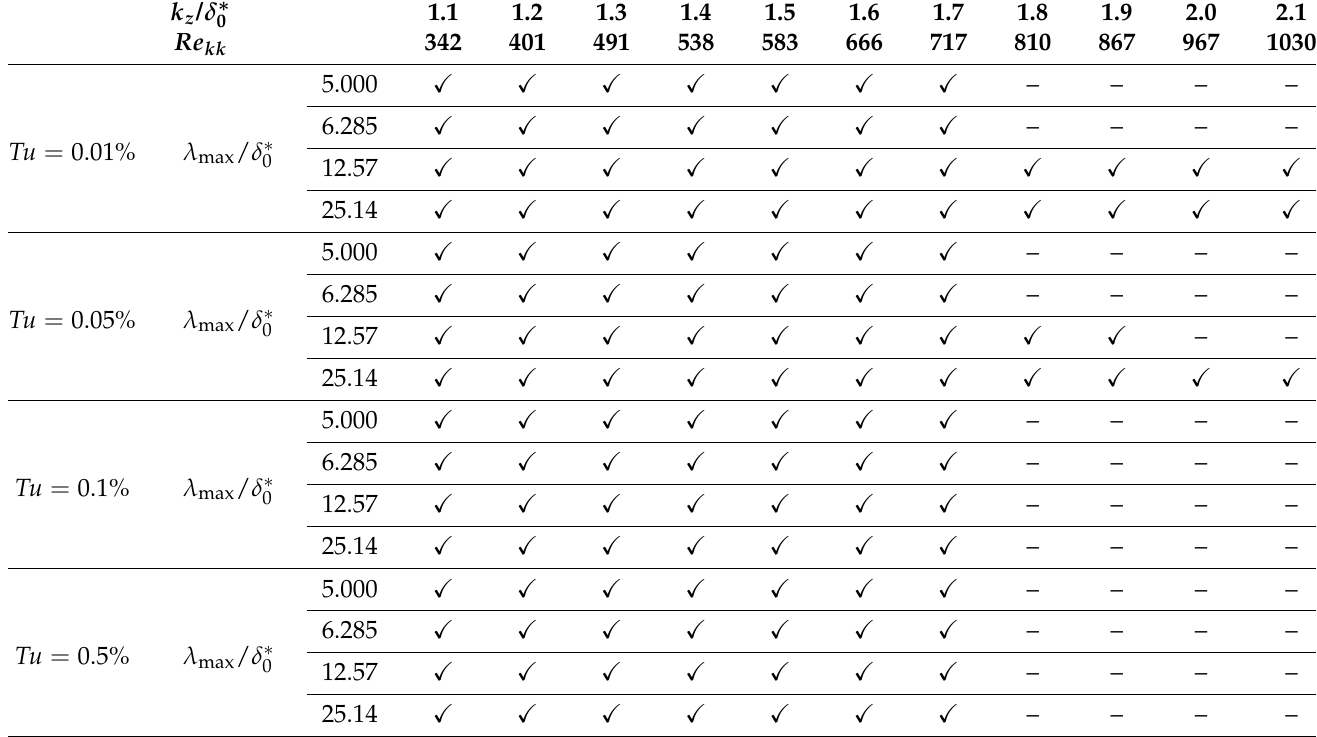
Table 2. Tested conditions in terms of roughness height or roughness Reynolds number, and FST intensity and wavelength: Check-marks indicate tested conditions, and hyphens mean